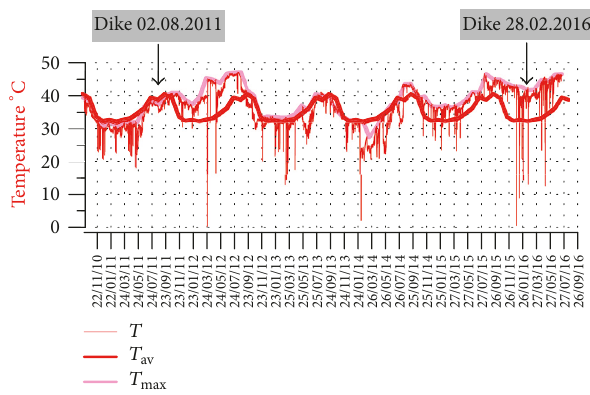
Figure 16: Temperatures recorded in Isotovsky hot spring and suggested times of dike injections in adjacent areas (#194, 2.08.2011 and #204, 28.02.2016). 𝑇 , observational data; 𝑇 , annual maximum av monthly temperature; 𝑇 , maximum monthly temperature. max